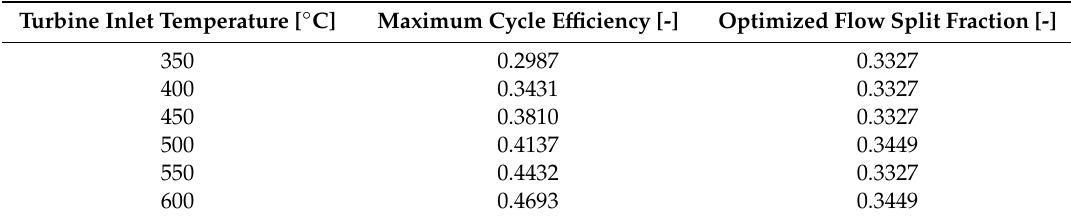
Figure 4. Cycle efficiency versus flow split fraction under different turbine inlet temperature values. Compressor inlet pressure is 7.4 MPa, temperature 31.25 ◦ C and turbine inlet temperature is 487 ◦ C. Table 2. Flow split versus turbine inlet temperature (compressor inlet pressure is 7.4 MPa, temperature 31.25 °C and turbine inlet temperature is 487 °C).